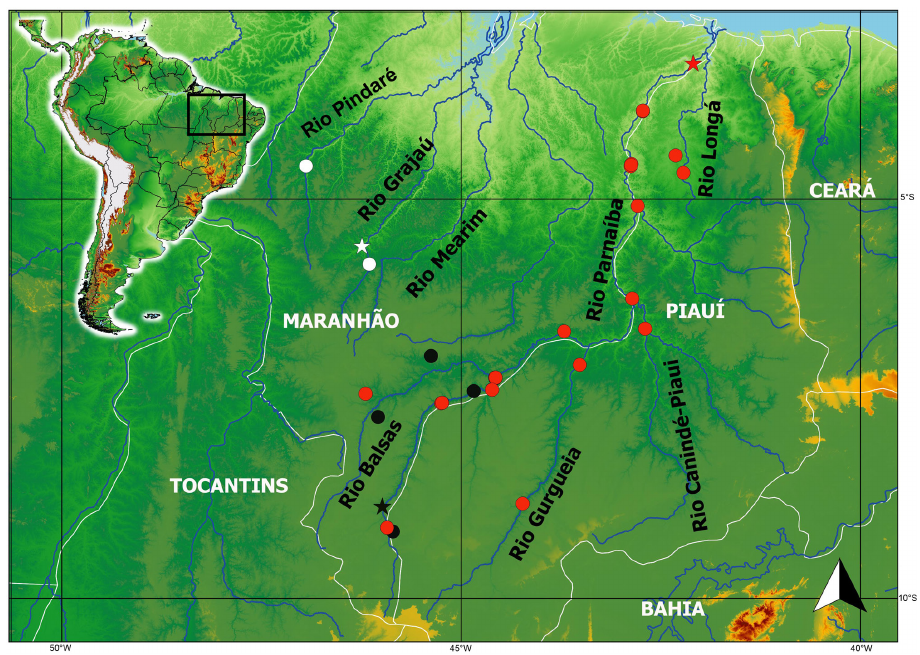
FIGURE 4 | Map of Northern Brazil showing distribution of Eigenmannia bumba (white), Eigenmannia cacuria (black), and E. robsoni (red). A star indicates the type